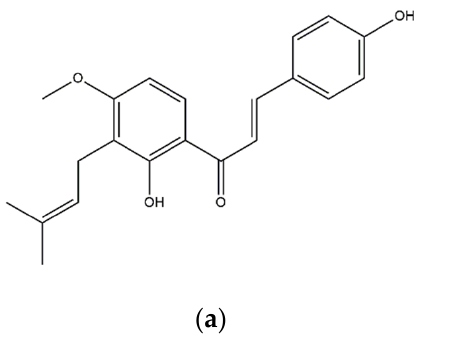
Figure 1. 2D structure of 4-hydroxyderricin (4-HD) ( a ) and sitagliptin ( b ) .